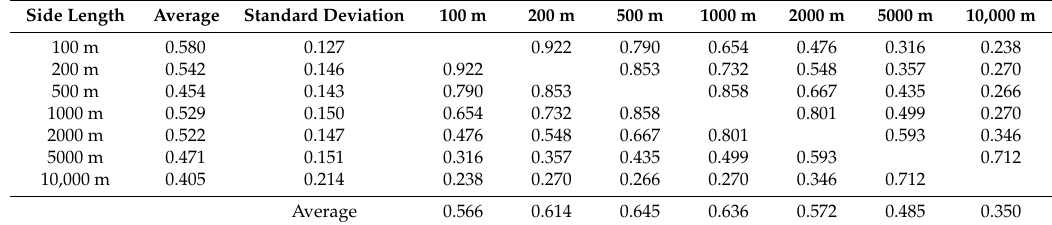
Table 16. Correlation matrix and basic statistic parameters for 1000 randomly selected control points. Side